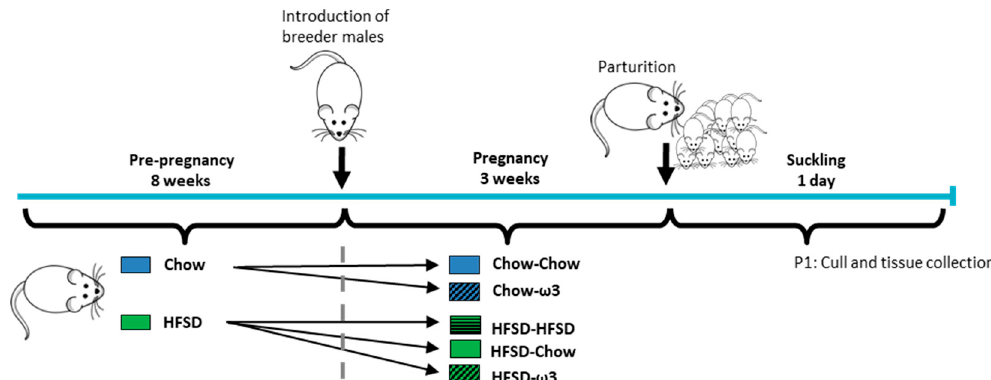
Figure 1. Experimental timeline. Six-week-old female rats were given either chow or high-fat-high-sugar diet (HFSD) for 8 weeks before the introduction of adult male studs. Following mating, female rats were separated into the following dietary regimens: those fed chow pre-conception were allocated to receive either chow or ω 3-enriched diets. Those fed HFSD pre-conception were allocated to either continue HFSD consumption during pregnancy, or to receive chow or ω 3 diets, resulting in the following group allocations: chow-chow; chow- ω 3; HFSD-HFSD; HFSD-chow; HFSD- ω 3. On postnatal day 1 (P1), dams and pups were culled and tissue collected for analyses.